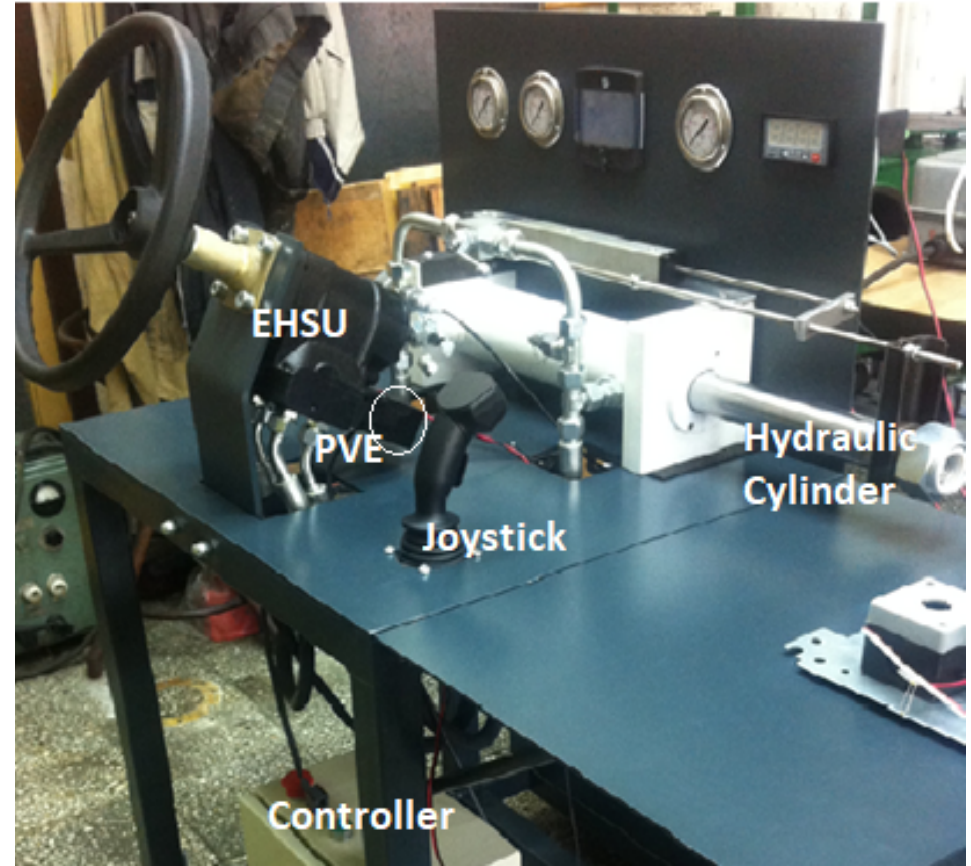
Figure 16. A photo of the laboratory test bench with its main functional